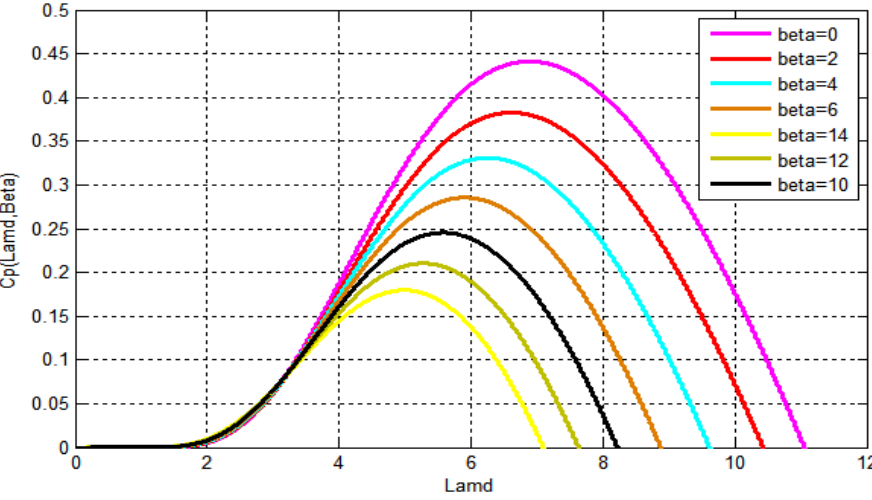
Figure 1. Typical Power Coefficient versus Tip-Speed-Ratio Curve.